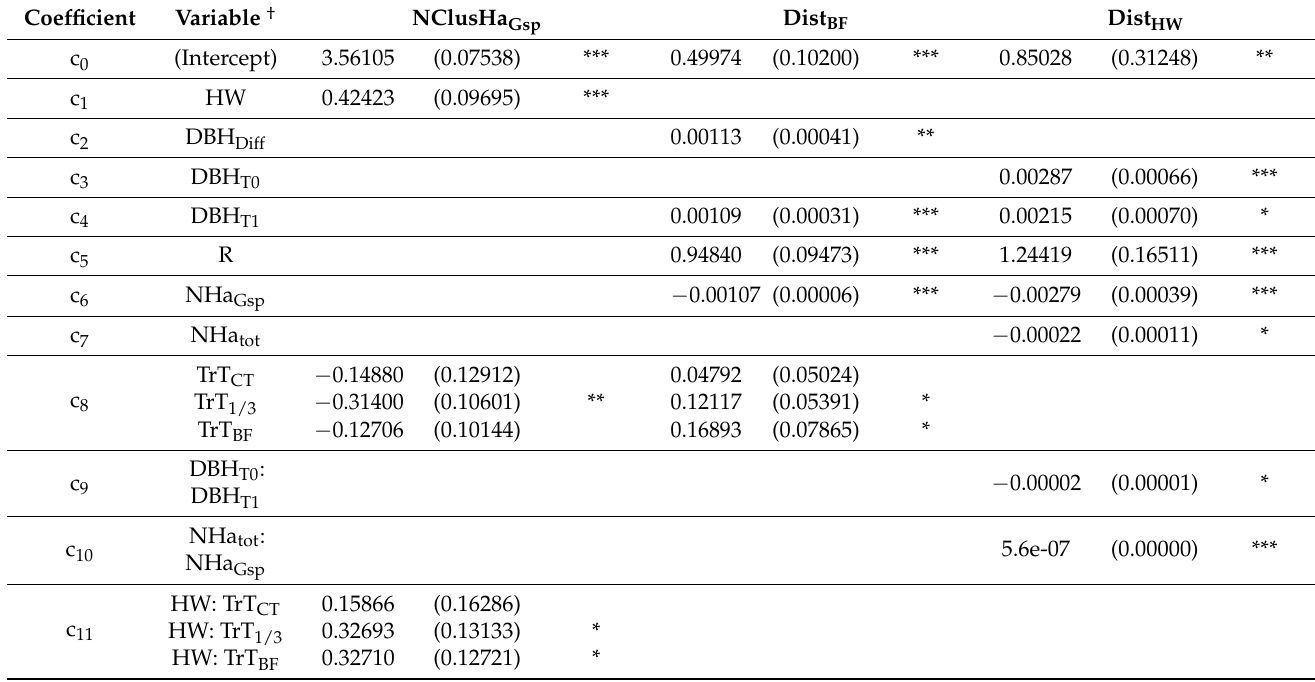
Table 5. Parameters estimations (standard error) of the models selected to predict intra-species spatial distribution (Equations (7)–(9)). (* p < 0.05; ** p < 0.001; *** p < 0.0001).